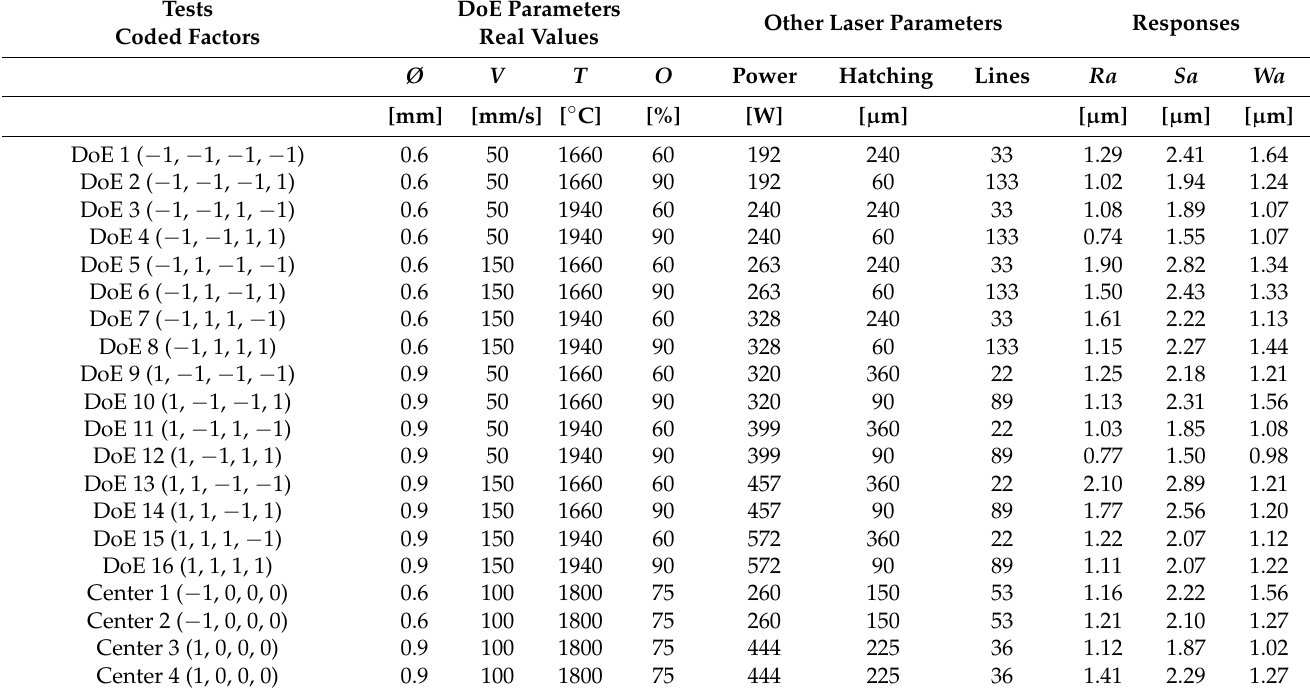
Table 2. Table of experiments including the coded values (first column) of the main parameters and the actual values (columns 2–5), other laser parameters calculated from the main parameters (column 6–8) and the responses issued from topography measurements (last 3